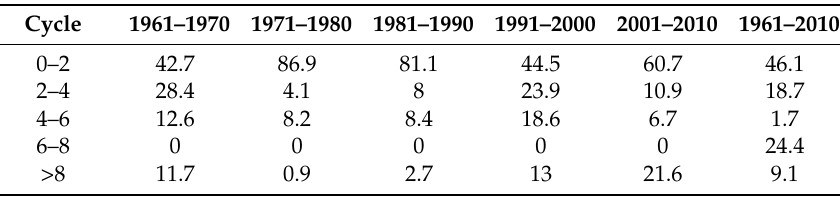
Table 4. Percentage of area covered by each cycle during the